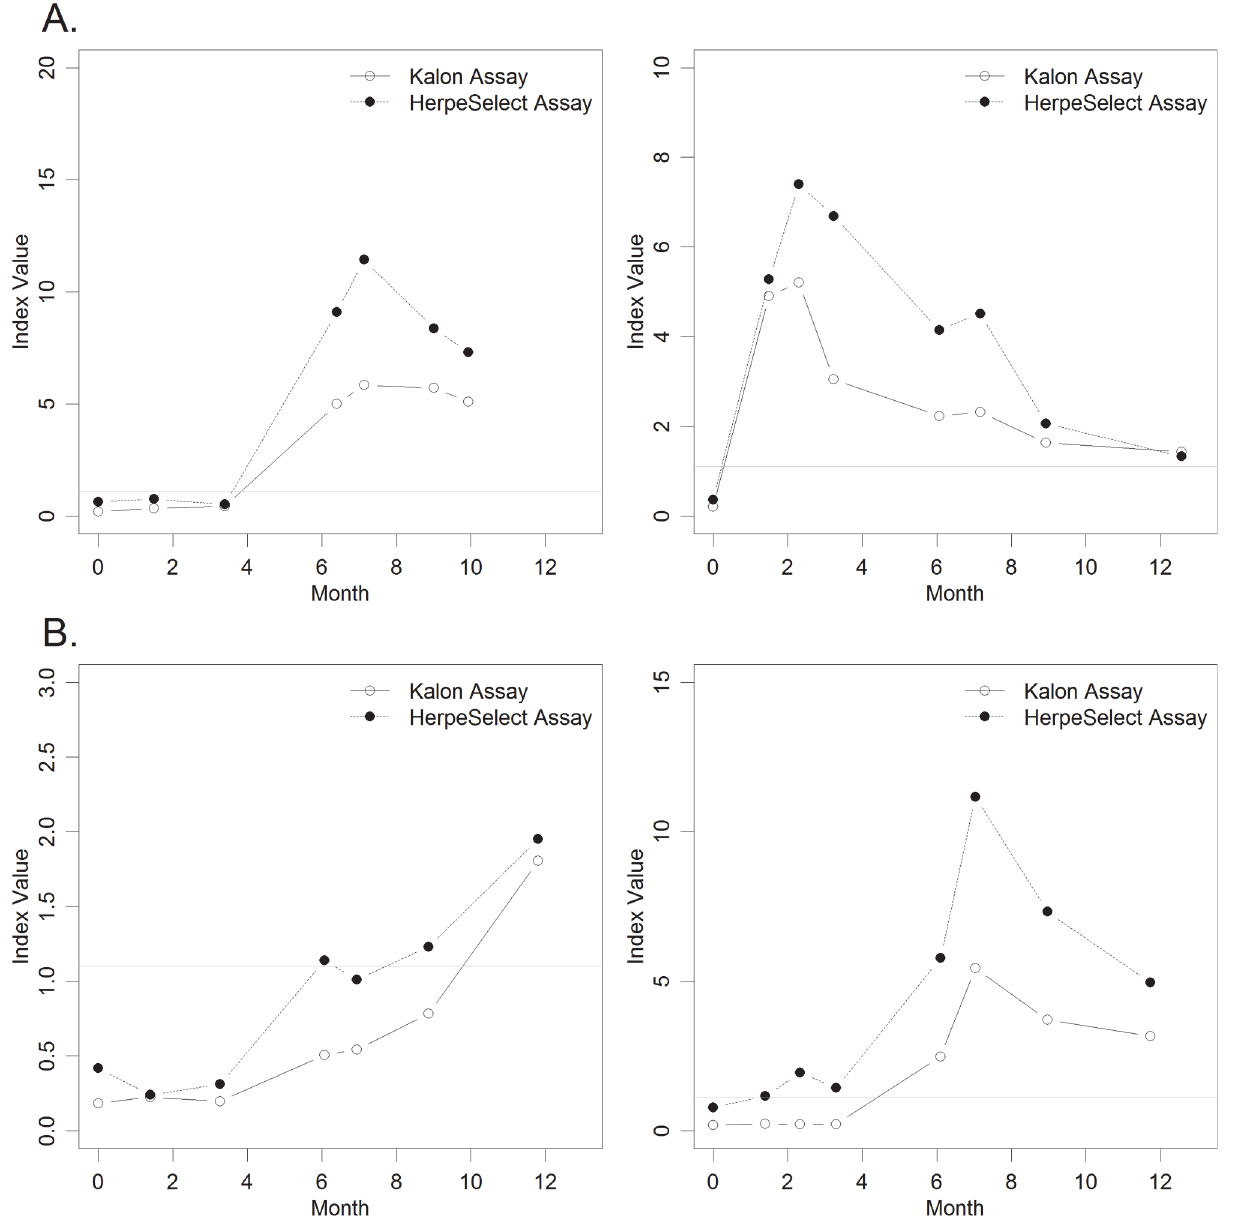
Fig 2. Longitudinal profiles. A. Incident profile with no delay in positivity for Kalon and HerpeSelect. B. Incident profiles with delayed increase of Kalon